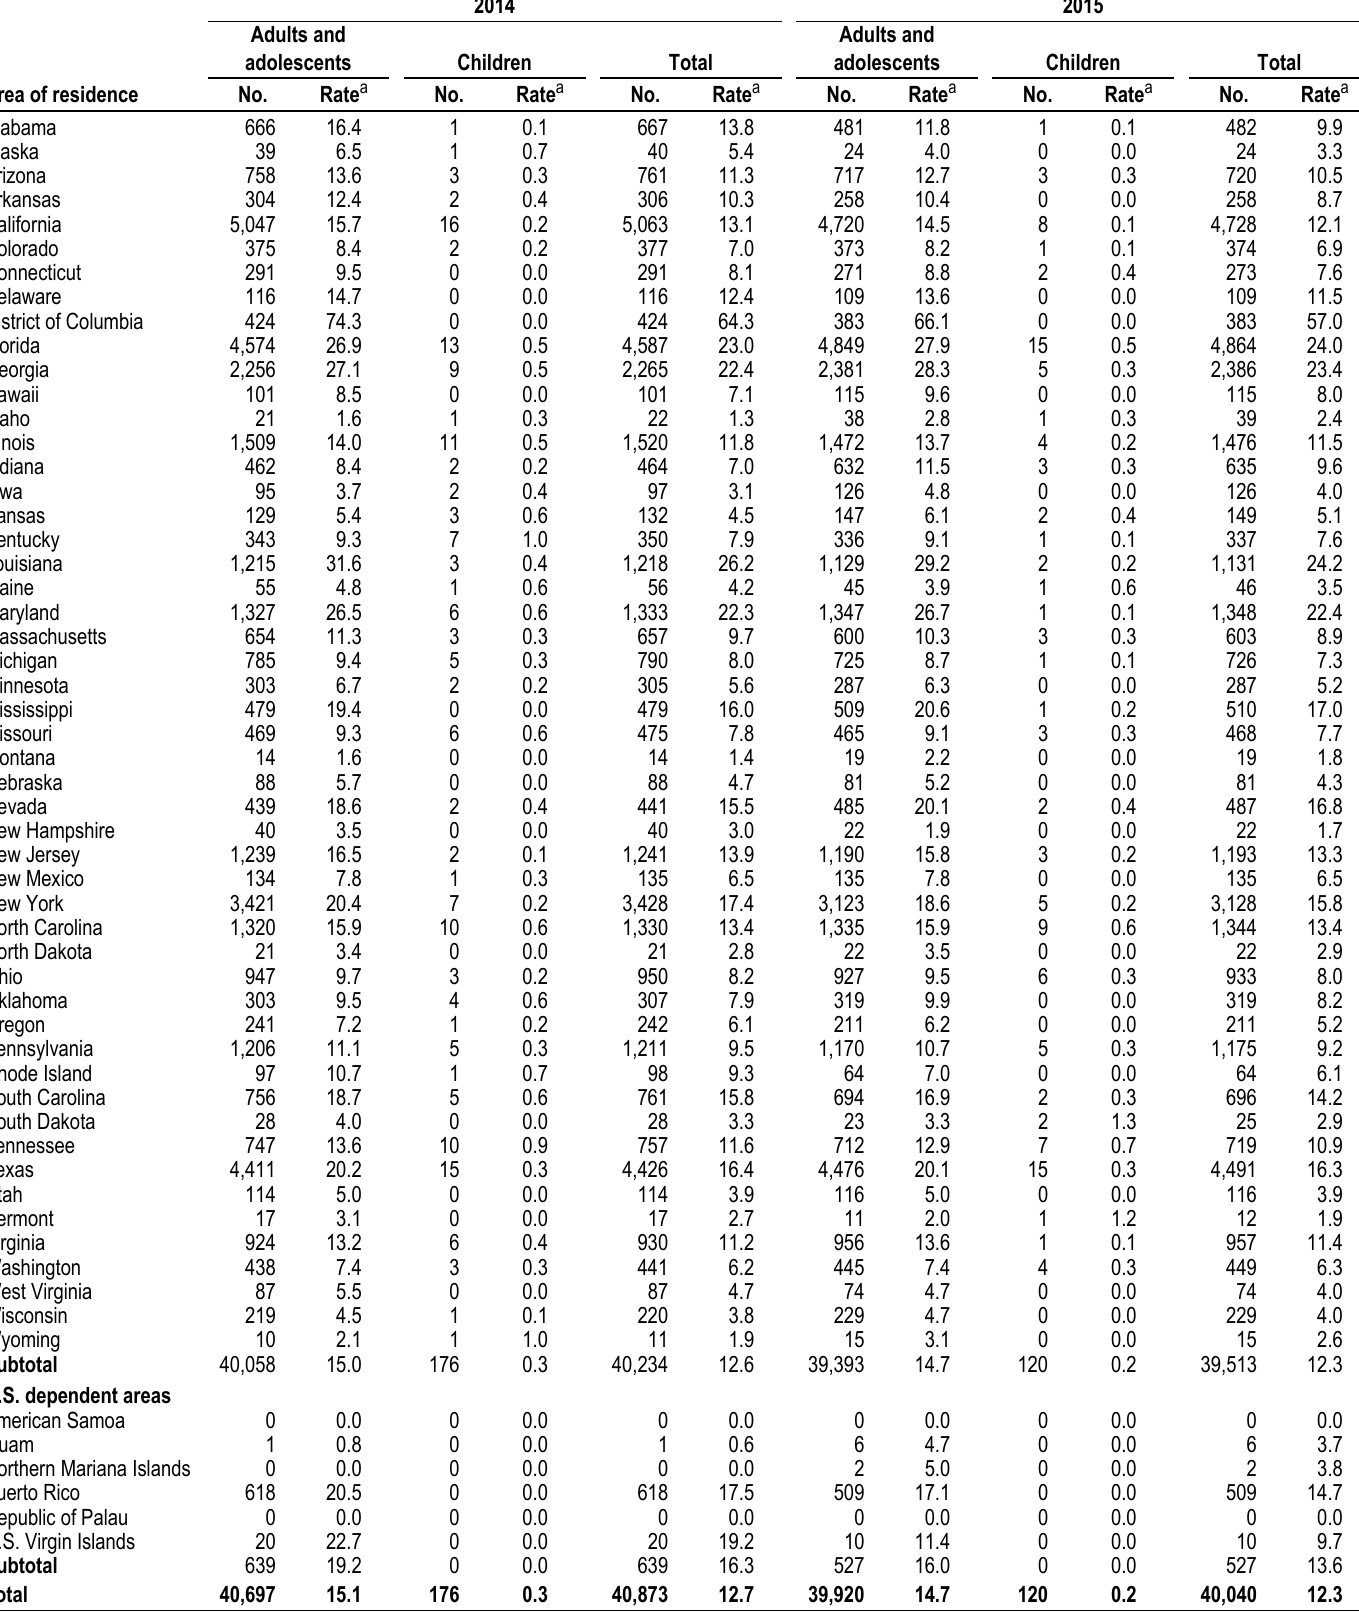
Table 22. Diagnoses of HIV infection, by area of residence, 2014 and 2015—United States and 6 dependent